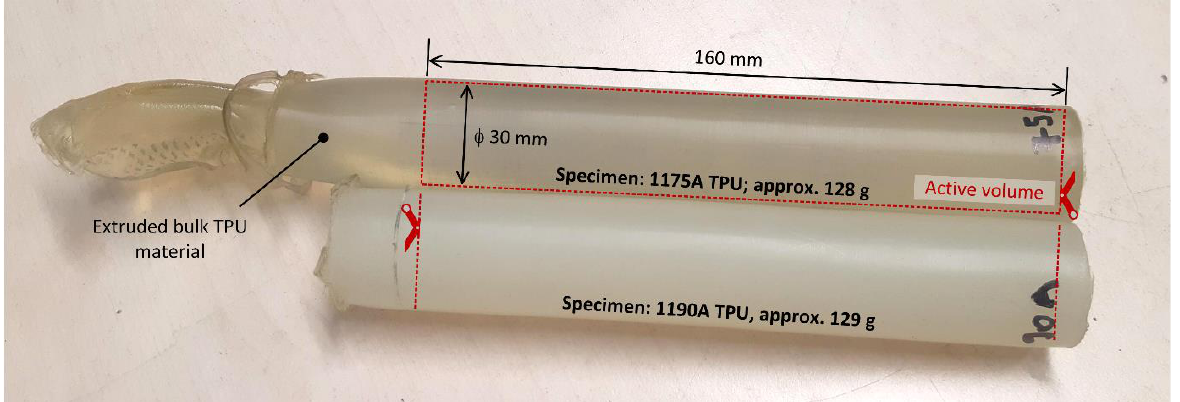
Figure 10. Experimental investigation of properties of base material — bulk material specimens.